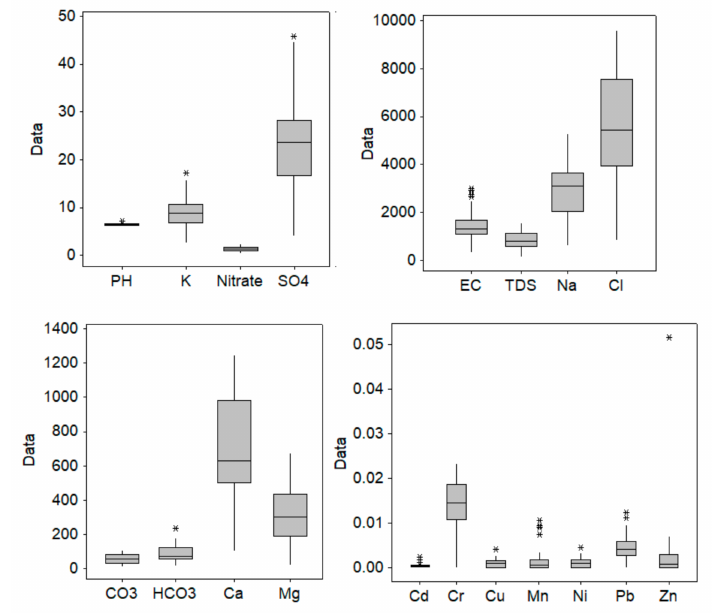
Figure 3. Boxplot of water